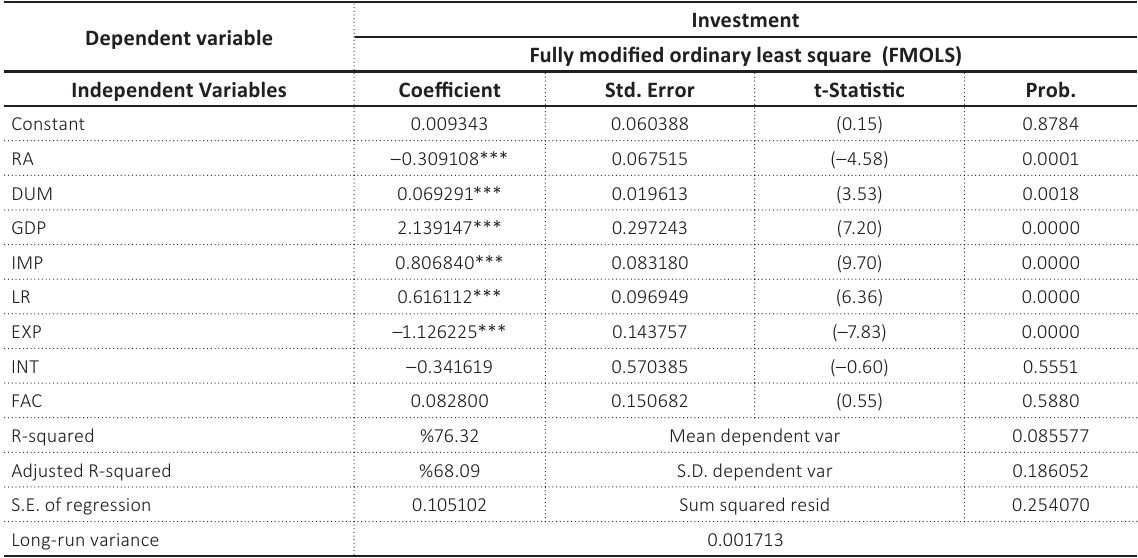
Table 5. Robustness analysis: corruption rank effect on Jordanian investment Dependent